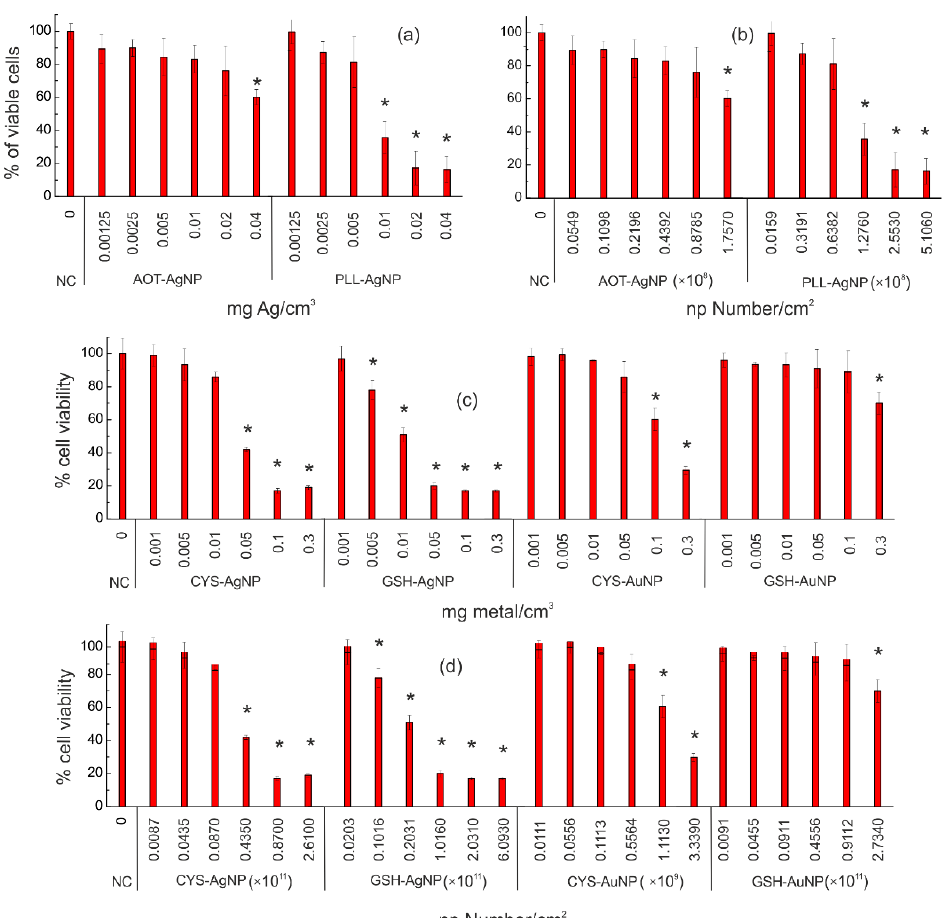
Figure 5. L929 cell viability after 24 h treatment with different concentrations of AOT- and PLL- coated AgNP ( a , b ), and L929 cell viability after 24 h treatment with different concentrations of CYS- and GSH-coated AgNP and AuNP ( c , d ). In ( a ) and ( c ), concentrations are expressed as the nominal concentrations, i.e., mg of metal per cm 3 of cell culture medium in the initial dispersion, while in ( b ) and ( d ) the results are presented as the response in cell viability using the calculated number of NPs deposited per unit area of the well bottom determined utilizing the “in vitro dosimetry” web application. Percentages of viable cells are expressed relative to the negative control (NC, cells treated with medium only). The values marked with an asterisk (*) differ significantly from the negative control ( p <